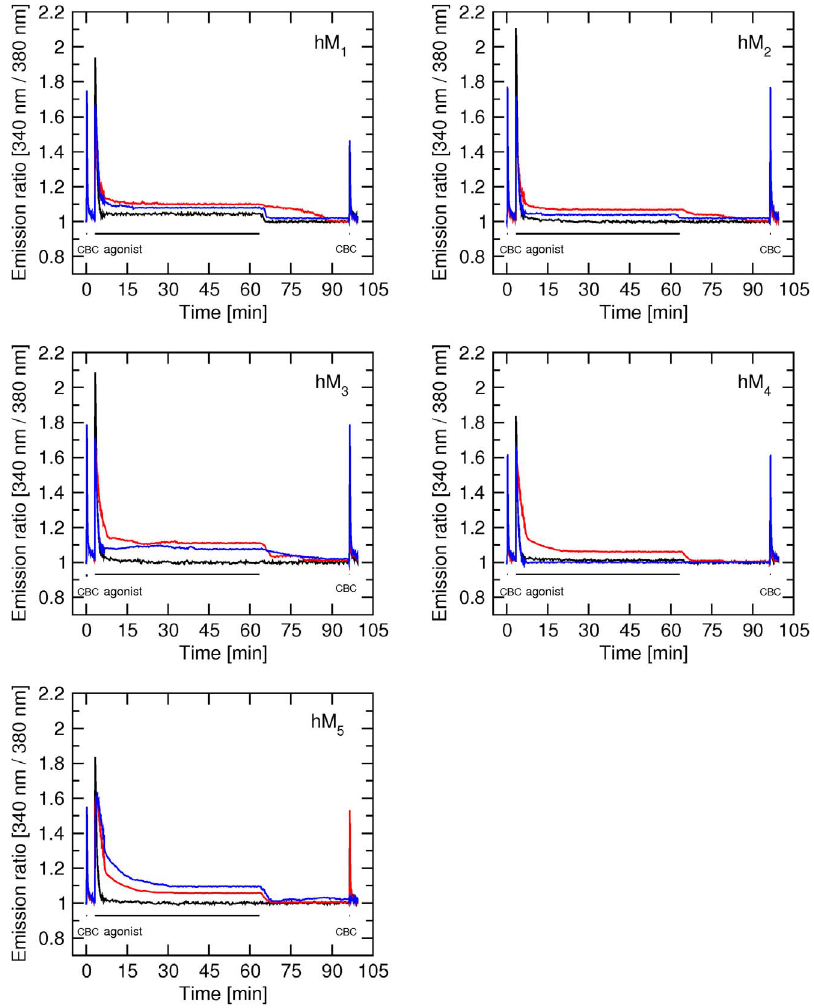
Figure 3. Effects of long-term application of classic agonists on the time-course of changes in intracellular calcium concentration in CHO cells expressing individual subtypes of muscarinic receptors. The time-course of changes in intracellular calcium concentration (abscissa) after stimulation of hM 1 to hM 5 muscarinic receptor subtypes with the agonists carbachol (CBC), oxotremorine and pilocarpine was measured as described in Methods. First stimulation: After 10 s of initial (resting) period 300 nM carbachol was applied for 10 s and then washed. Second stimulation: Three min after the first stimulation either 1 m M carbachol (black curve) or 1 m M oxotremorine (red curve) or 3 m M pilocarpine was applied for 1 hour followed by 30-min washing. Third stimulation: After washing following the second stimulation 300 nM carbachol was applied for 10 s followed by washing. Intracellular calcium concentration (ordinate) is expressed as fluorescence intensity (340 nm/380 nm) ratio normalized to basal calcium level. Representative traces are averages of 12 to 16 best responding cells from one experiment. Signal variation (SD) among cells ranges from 6 0.018 at the base line to 6 0.067 at peaks. Results were confirmed in 2 additional independent experiments. Parameters of agonist effects are summarized in Table S5 in File